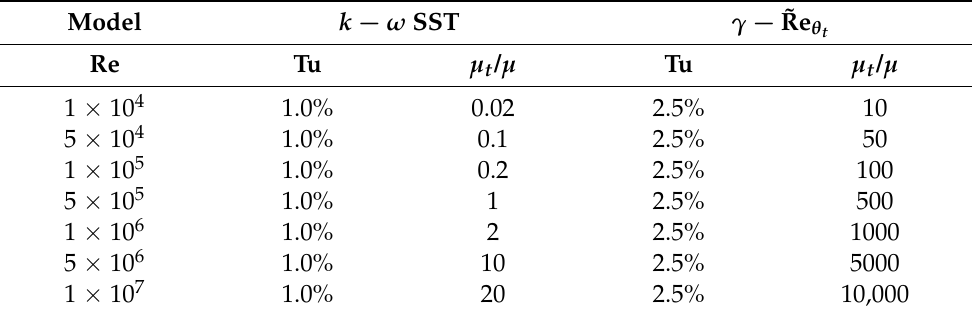
Table 1. Inlet turbulence quantities for the calculations at different Reynolds